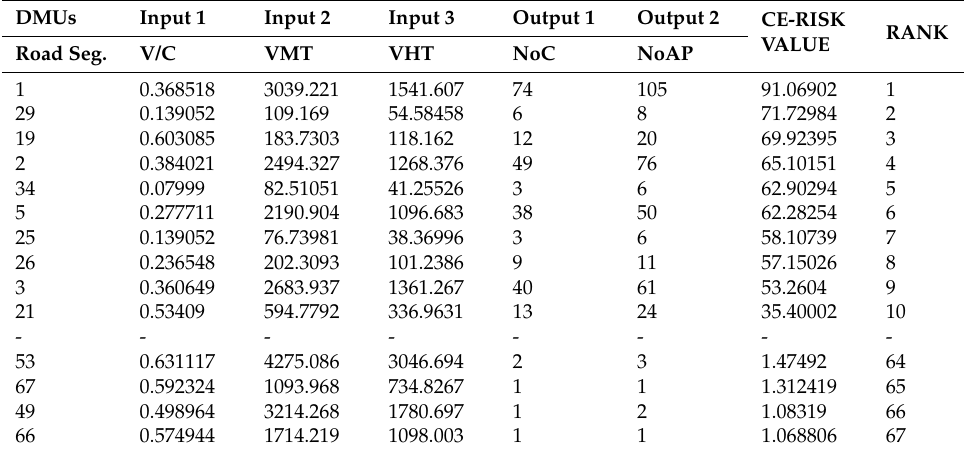
Table 3. DEA-Based Risk Evaluation and Ranking Segments.